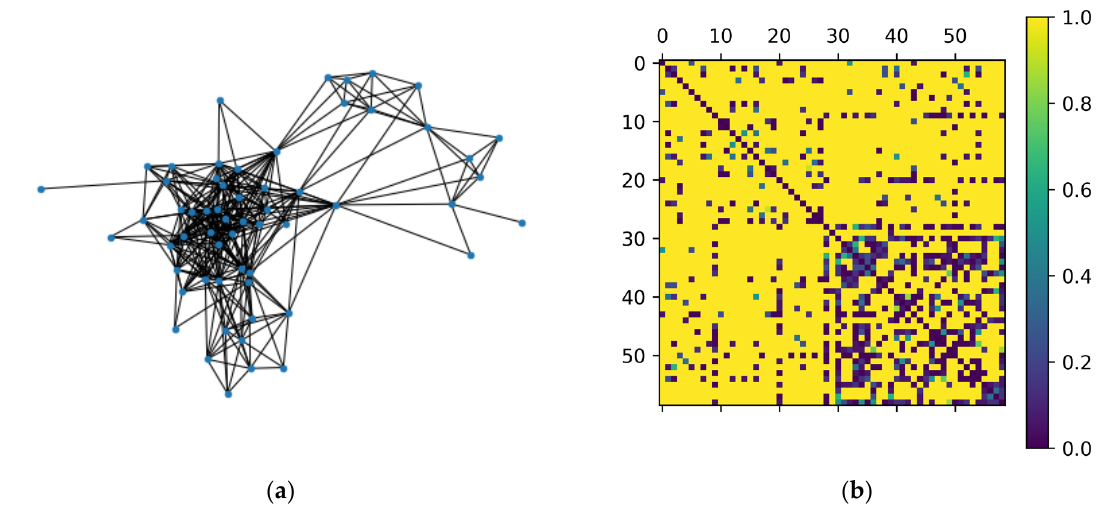
Figure 5. ( a ) Graph visualization of 59 bus routes; ( b ) Visualization of adjacency matrix of the weighted graph.